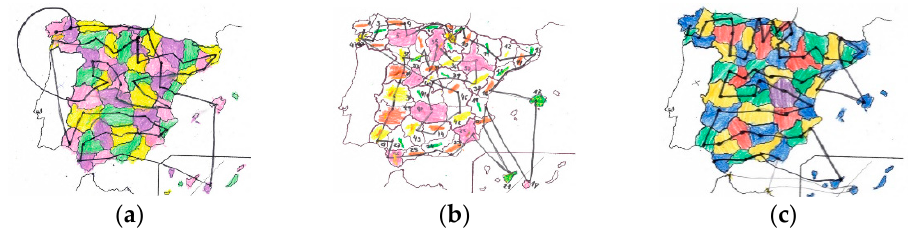
Figure 4. Failed attempt of Eulerian cycle. Drawing made by participant: ( a ) A1; ( b ) A4; ( c ) A6.